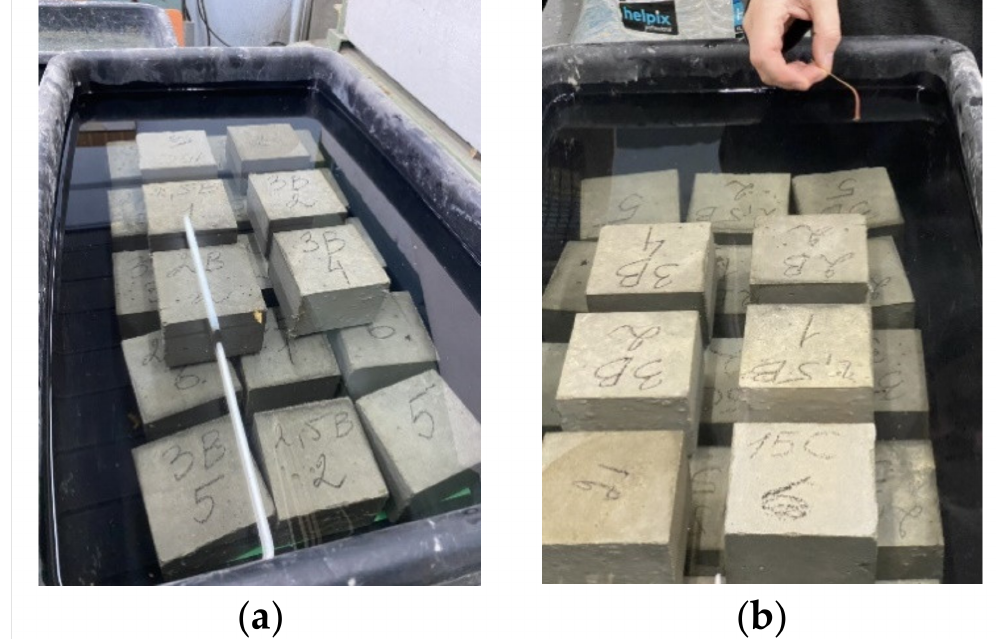
Figure 10. Acid environment test, pH = 3. Total amount of specimens 84 cubes (12 cubes for each batch). ( a ) control specimens; ( b ) specimens in acid environment.